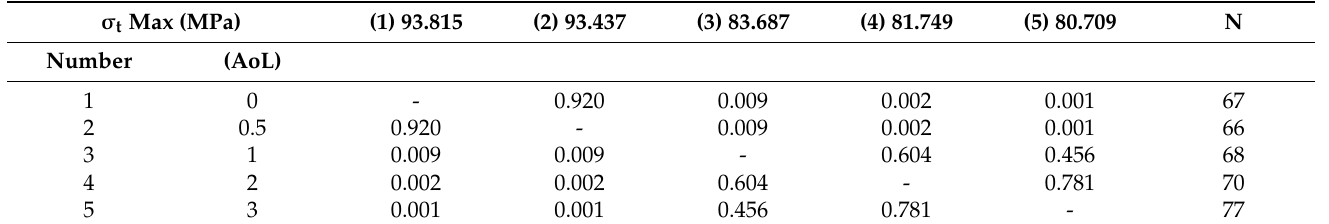
Table 3. Statistical evaluation of the effect of log age (AoL) on tensile strength using Duncan’s test.